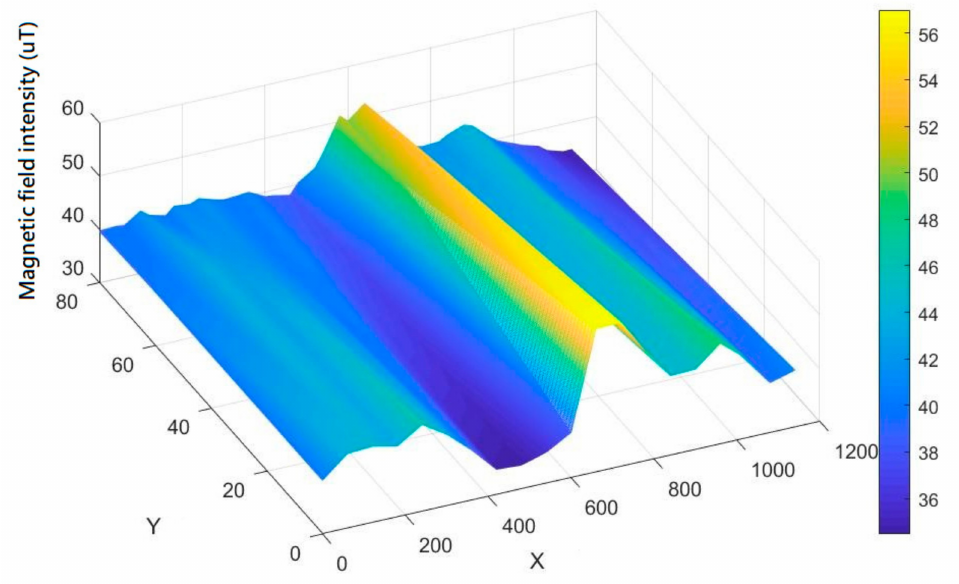
Figure 7. Schematic diagram of indoor magnetic field